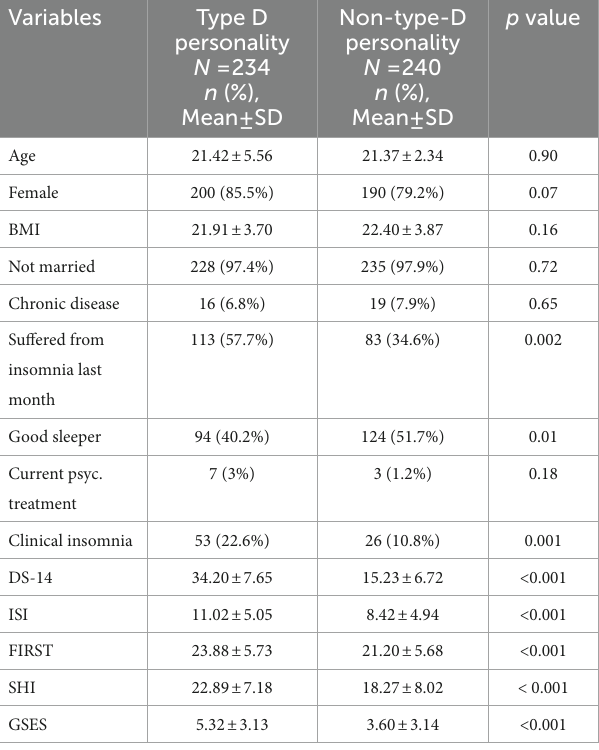
TABLE 2 Comparison of sociodemographic and sleep variables between the group with and without Type D personality.